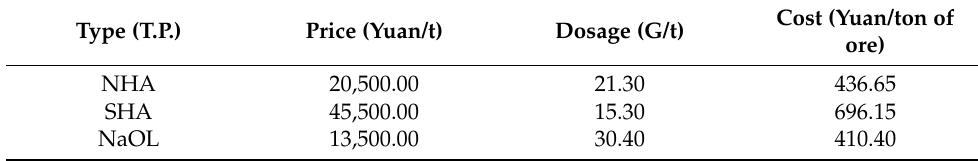
Table 4. Cost estimation of flotation agent consumption in industrial